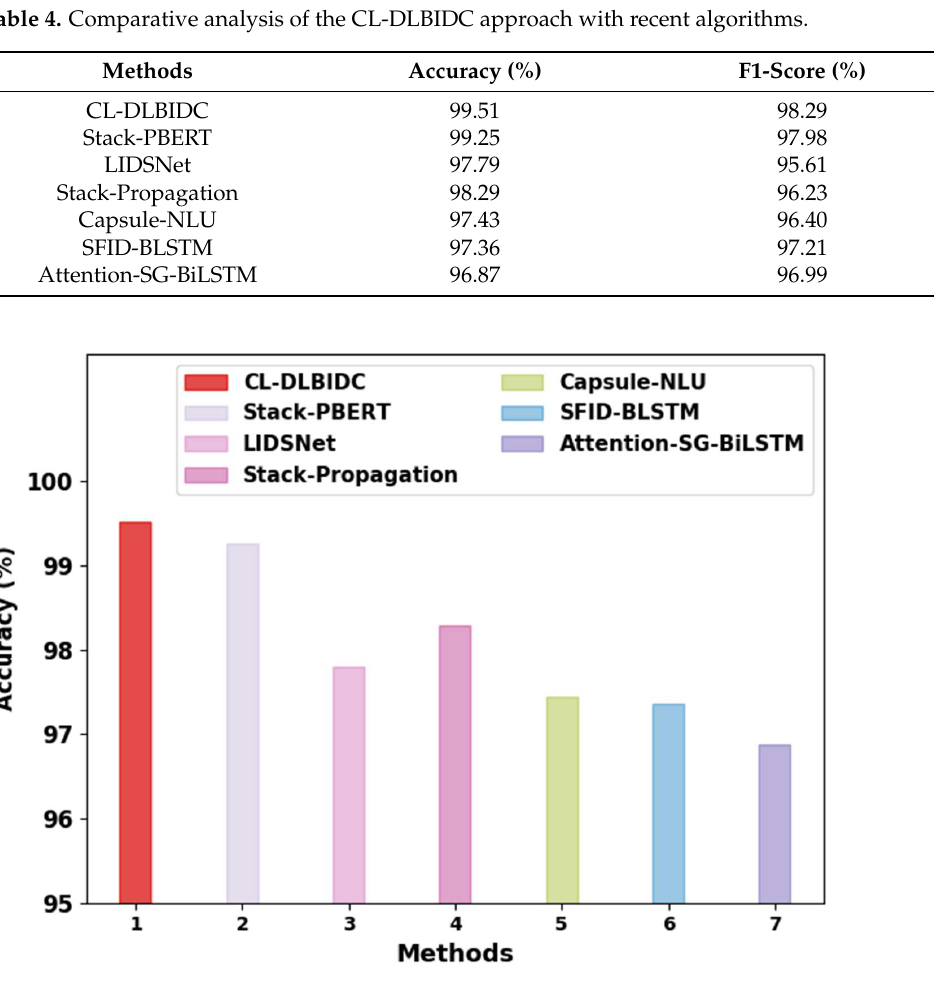
Figure 8. Accu y analysis of the CL-DLBIDC approach with recent Figure 8. analysis of the CL-DLBIDC approach with recent algorithms (cid:13)!!C u